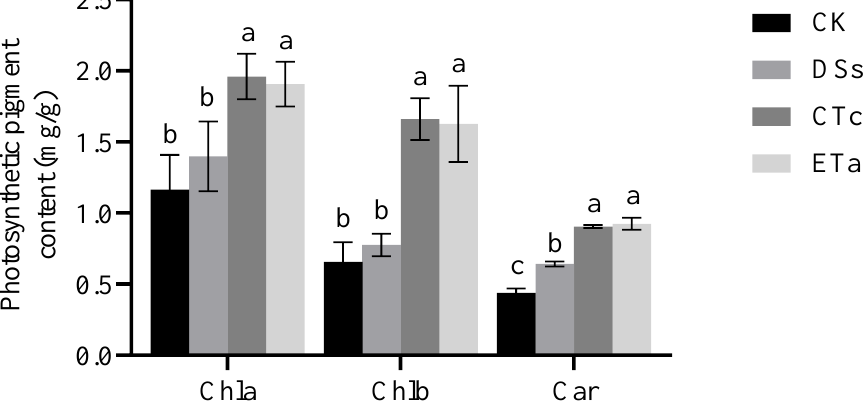
Figure 5. The content of photosynthetic pigments in leaves of the four treatment groups. Color bars of each group from left to right are chlorophyll a (Chla), chlorophyll b (Chlb) and carotenoid (Car). Different lowercase letters are significantly different ( p < 0.05) based on Tukey tests.